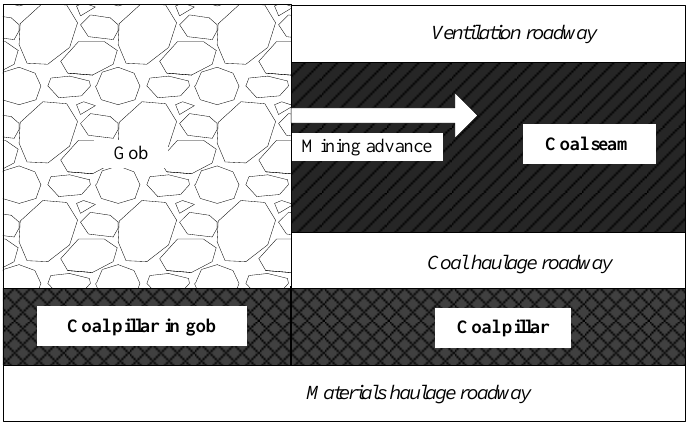
Figure 4. Placement of coal pillars in the gob.